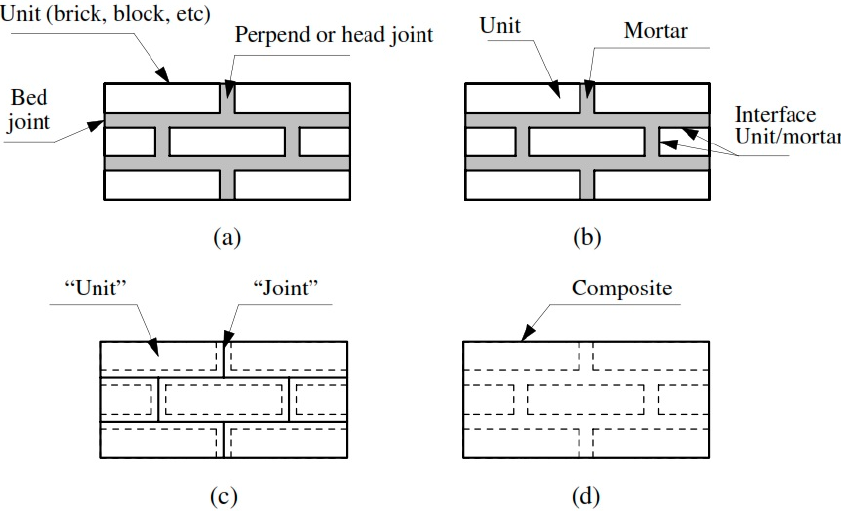
Figure 3. Modeling strategies for masonry: ( a ) typical masonry specimen; ( b ) detailed micro-modeling; ( c ) simplified micro-modeling; and ( d ) macro-modeling (Lourenço, 1996 [100]).